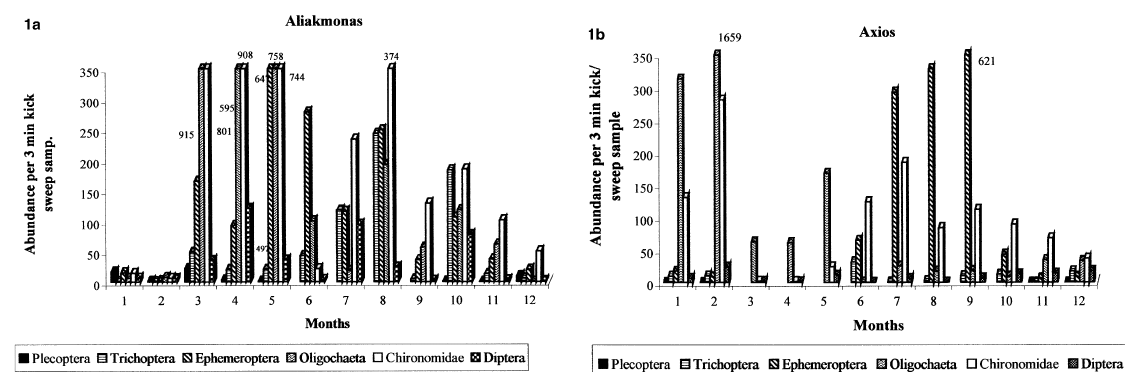
Fig. 1. Monthly fluctuations of the abundance of the benthic macroinvertebrate groups in two sites in Aliakmon (a) and Axios (b)